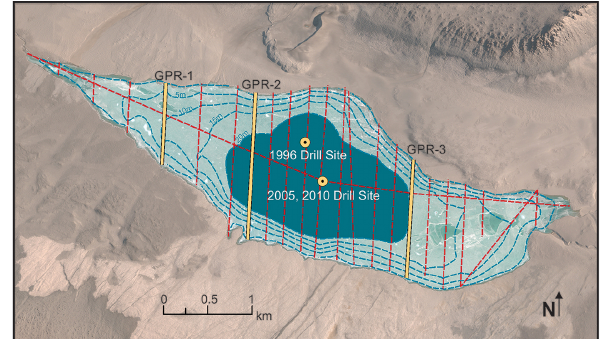
Figure 1. Location of drill sites and GPR transects (red dashed line) on Lake Vida in central Victoria Valley © DigitalGlobe (2011). Highlighted GPR transects 1–3 are presented in the paper. Bathy- metric lines 0–20m were digitized and interpolated from GPR pro- files. The dark blue area below 20m is of unknown